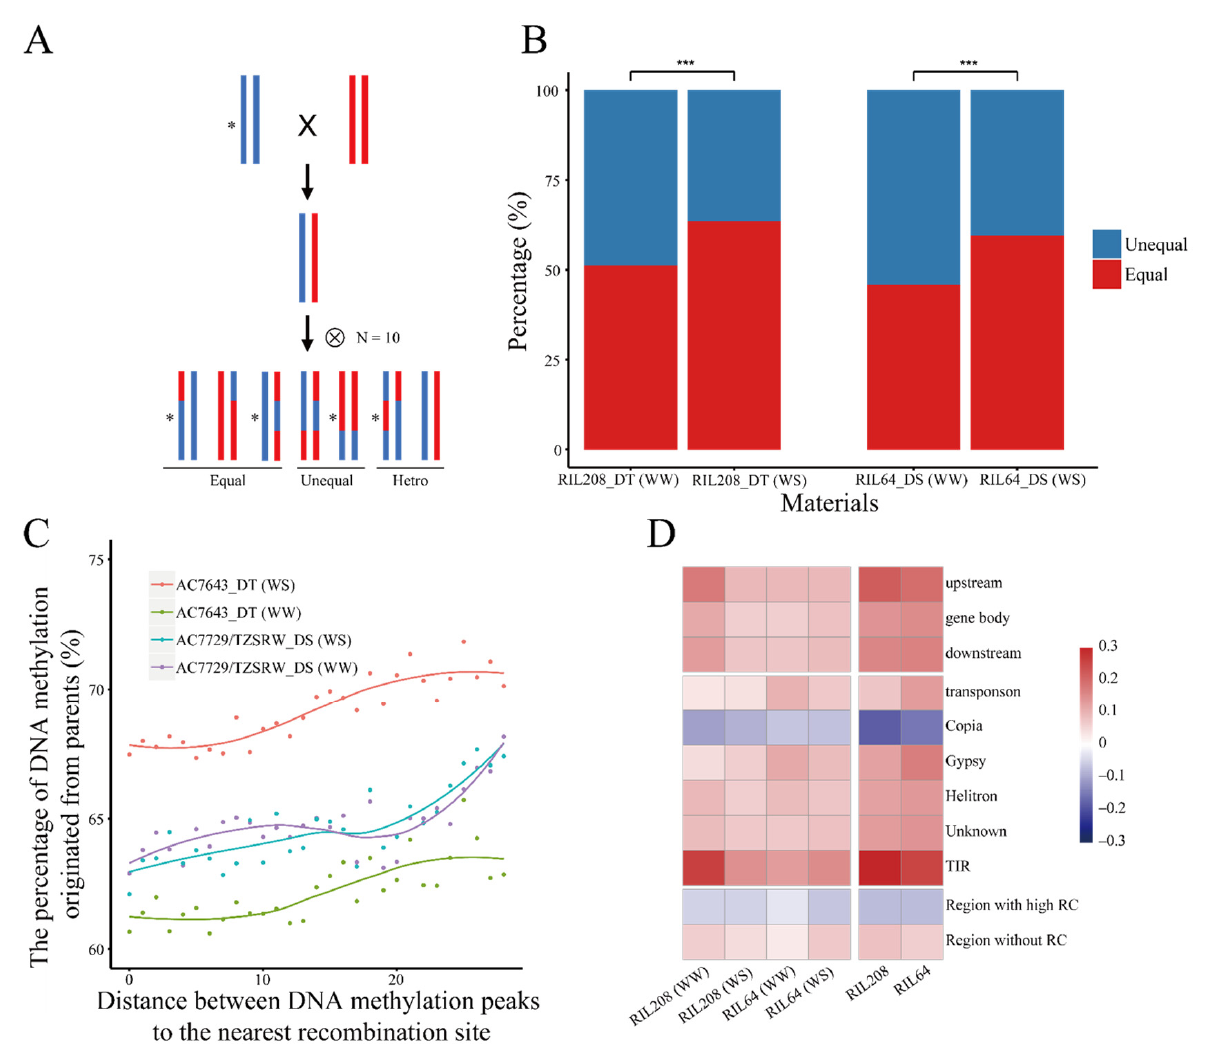
Figure 2. The inheritance of DNA methylation. ( A ) The diagram of the DNA methylation relationship of the RILs and sequence-origin parental lines. The blue and red bars mean DNA sequences originated from the two parental lines, respectively. The asterisk represents the existence of DNA methylation peaks. ( B ) The histogram of the proportion of DNA methylation peaks in RILs consistent with those of the corresponding parental line. WW: Well Water, WS: Water Stress. ***: p < 0.001, χ 2 test. ( C ) The xy-plot of the proportion of DNA methylation peaks in RILs consistent with that of the parental lines and the distance to the nearest recombination site. ( D ) The heatmap of the conservation of DNA methylation in different regions. Data was normalized by random DNA segments of length equal to DNA methylation peaks. RC: